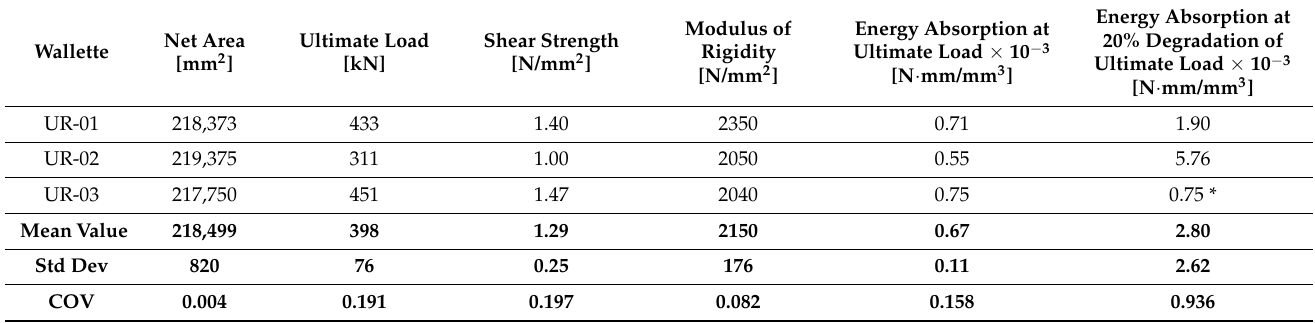
Table 9. Ultimate load, shear strength, and modulus of rigidity, and energy absorption of Type 2